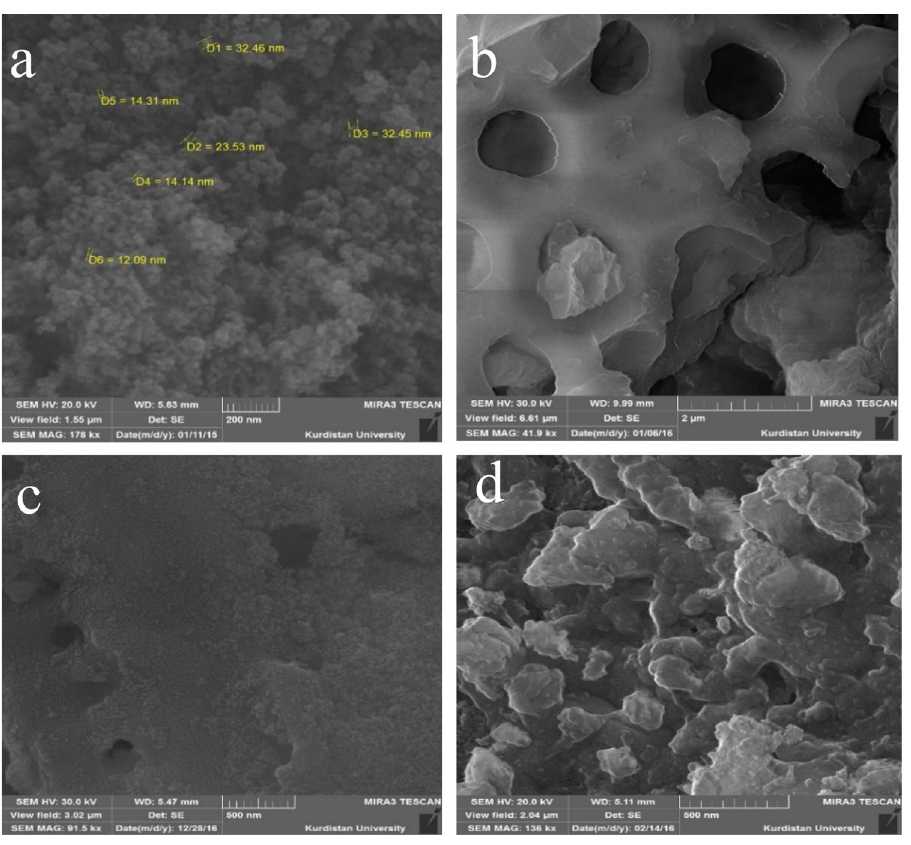
Figure 1. SEM images of nano-sized Fe 3 O 4 ( a ), biosilica ( b ), biosilica/Fe 3 O 4 ( c ) and MBA nano-hybrid ( d